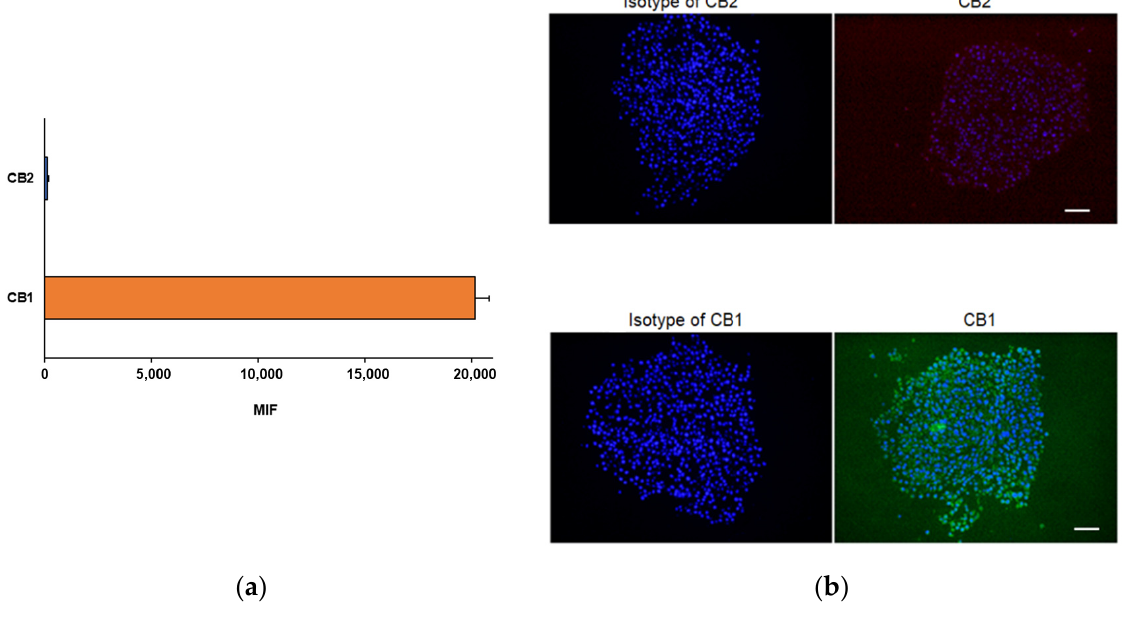
Figure 8. ( a ) Flow cytometric and ( b ) immunofluorescence analyses of the cannabinoid receptor expression in D384 spheroid sections. A higher expression of CB1 receptors was observed compared to CB2 expression, as demonstrated by both flow cytometry and immunofluorescence staining. The flow cytometry data are expressed as median fluorescence intensities (MFIs) and represent the means ± S.D. The images show representative fluorescence-merged microphotographs with CB1-positive (green fluorescence) and CB2-positive (red fluorescence) areas in D384 spheroid sections. Nuclei were stained with Hoechst 33258. Scale bar: 100 µm.